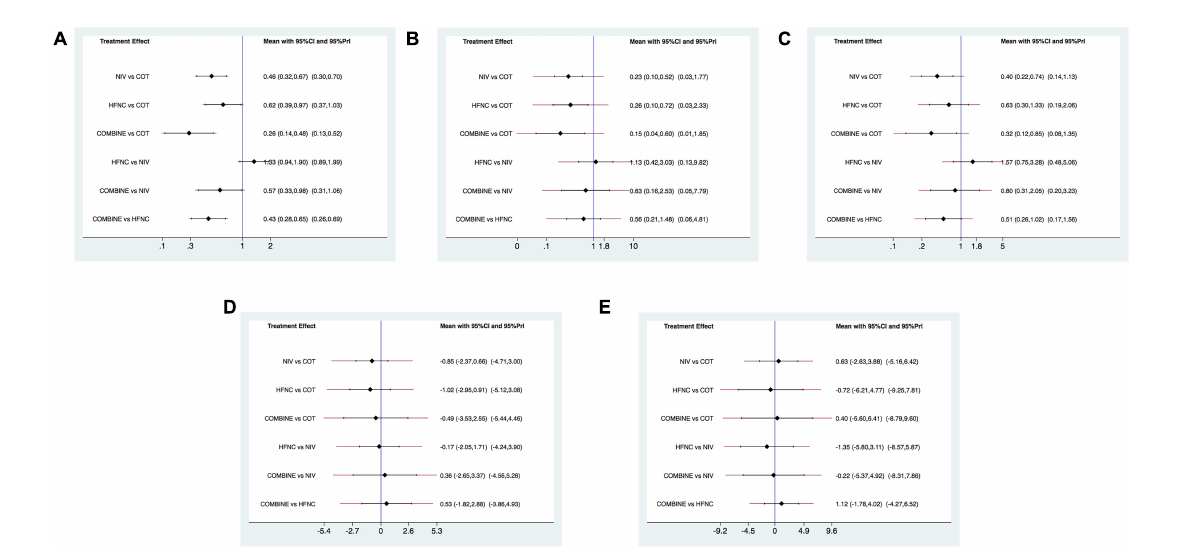
FIGURE3 Forest plots for reintubation rate, respiratory failure, ICU mortality, ICU stay, and LOS. (A) Reintubation rate; (B) respiratory failure; (C) ICU mortality; (D) ICU stay; (E) LOS. ICU, intensive care unit; LOS, length of stay; NIV, non-invasive ventilation; COT, conventional oxygen therapy; HFNC, high-flow nasal cannula; CI, confidence interval; Prl, prediction interval.